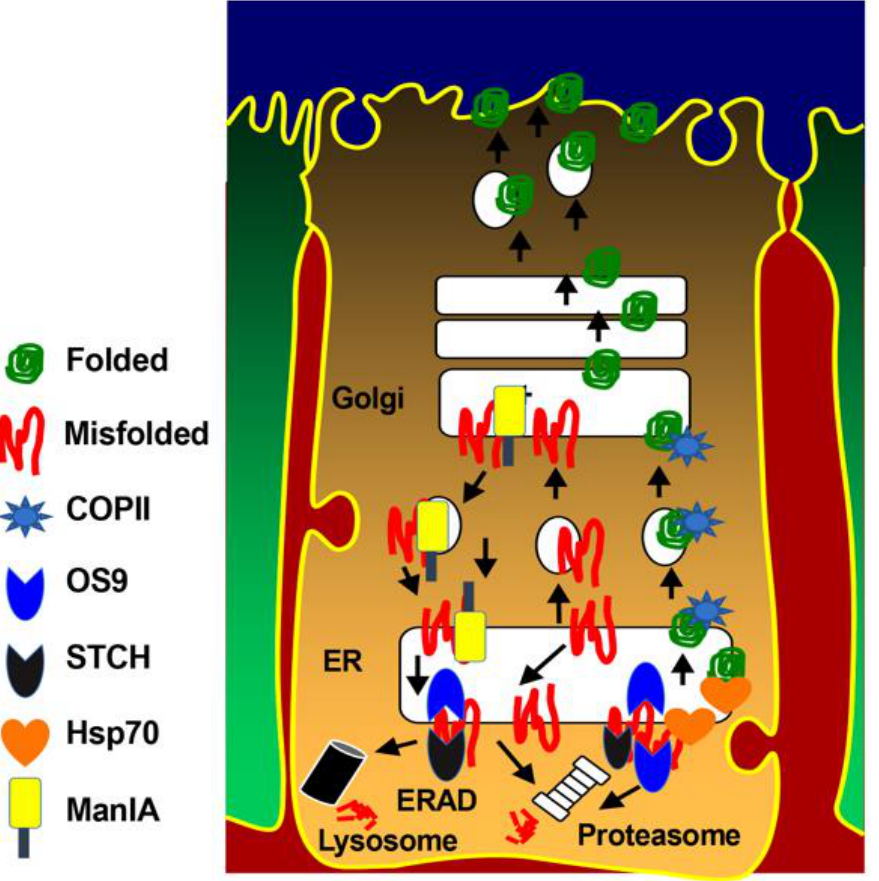
Figure 8. Molecular determinants of NKCC2 ER export and ER-associated degradation. Properly folded NKCC2 proteins use di-leucine like motifs and di-acidic codes to exit the ER through the COPII budding machinery. OS9 mediates the retention of misfolded NKCC2 proteins at the ER and their ERAD by the proteasome [27]. STCH role in the ERAD of NKCC2 involves both the proteasome and lysosome pathways [31]. Golgi ManIA promotes efficient ERAD of NKCC2 by capturing misfolded NKCC2 proteins that escaped ER quality control and delivers them back to the ER [29]. Finally, Hsp70 protects NKCC2 against ERAD and promote its maturation